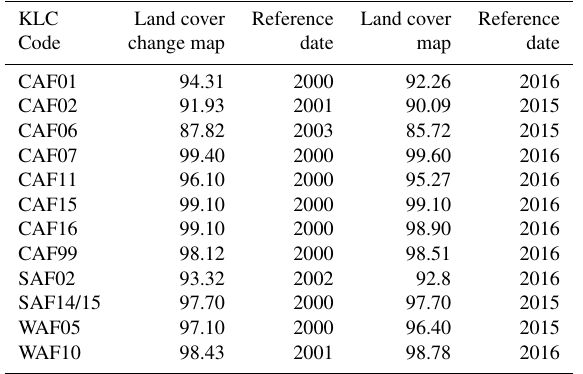
Table 4. Achieved overall accuracies for land cover mapping (%). KLC Land cover Reference Land